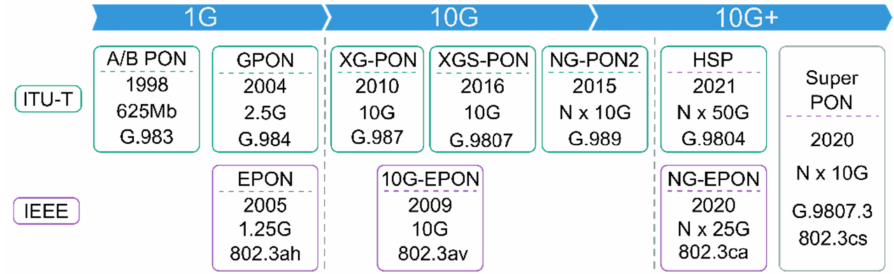
Figure 2. PON standards/task force evolution of max aggregated bandwidth in DS direction over